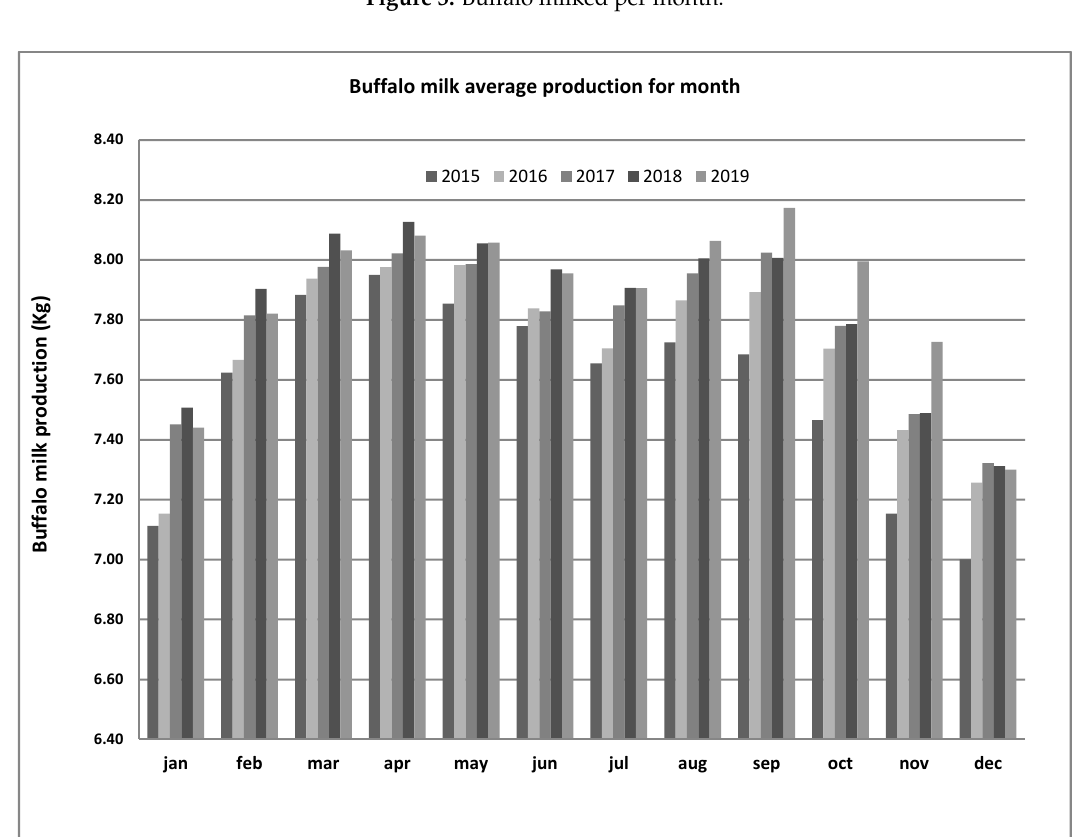
Figure 4. Average milk production per month.